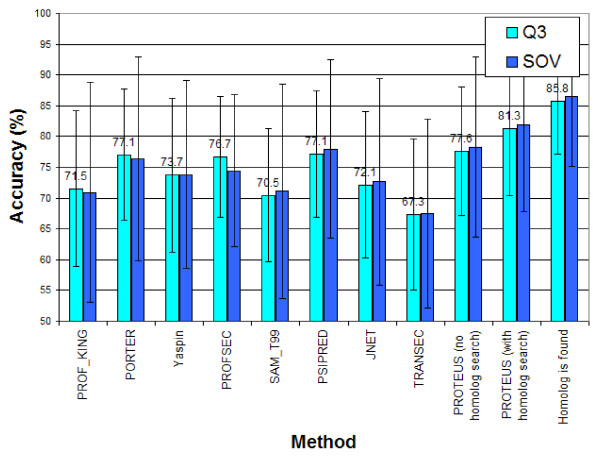
Hisotgram comparing the Q3 (light) and SOV (dark) scores of PROTEUS (right 3 bars) versus PSIPRED, JNET, and TRANSSEC for the test set (N = 1644) of non-homologous EVA sequences. Data for YASPIN, PORTER, PROF-KING, PROFSEC, and SAM-T99 are also shown. These were calculated from a smaller (N = 30–39) subset of sequences and predictions posted on the EVA website and on the PROTEUS home page. The Q3 score is written at the top of each predictor's set of bars. Standard deviations are shown as error bars.